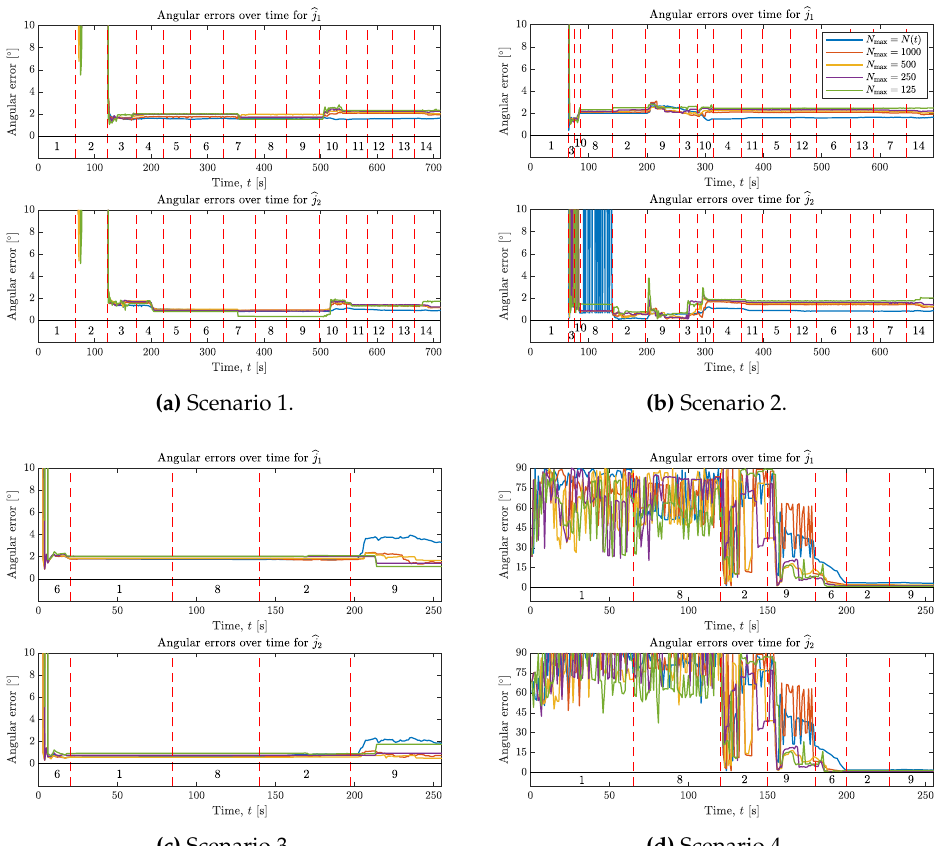
Figure 6. Angular errors over time for the four scenarios, see ( a – d ). Comparing the case N max = N ( t ) , where all samples up to time t are used for estimation to N max ∈ { 1000,500, 250,125 } samples being chosen by Algorithms 2–3 at each integer t seconds. Colored lines define these different cases as given by the legend in the top right. Vertical dashed lines and the numbers 1–14 are used to indicate from which motions (see Section 7.1) the data comes from.